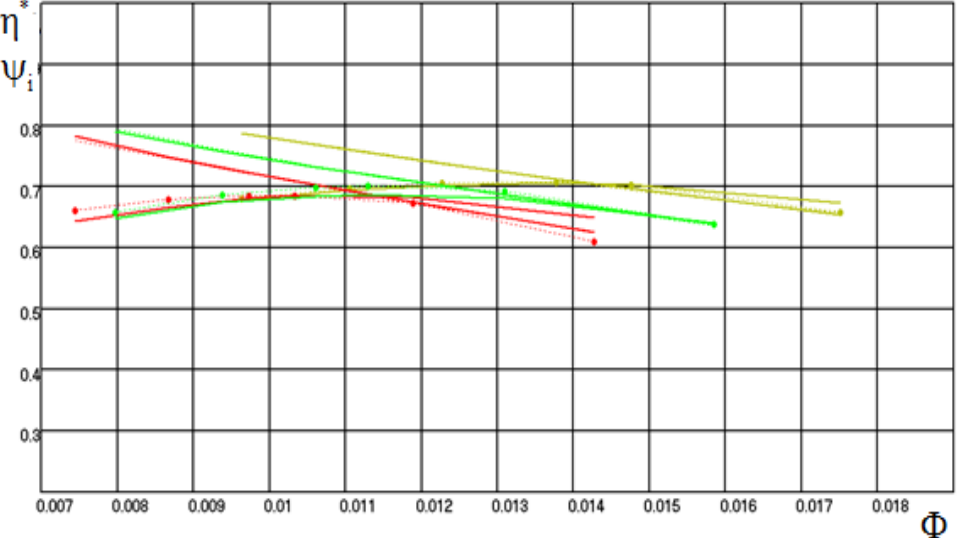
Figure 9. IDENT program. Characteristics of the Clark model stages (dashed lines), and their calculated characteristics (solid lines).